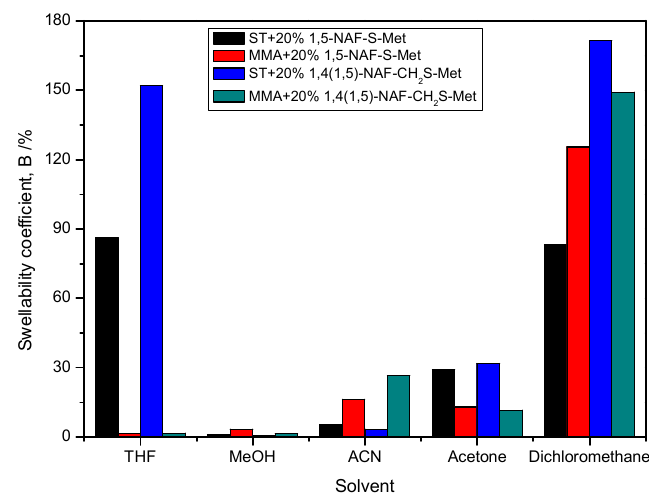
Figure 13. The swelling coefficients of obtained MMA and ST polymers with 20% addition of1,5-NAF-S-Met and 1,4(1,5)-NAF-CH 2 S-Met.